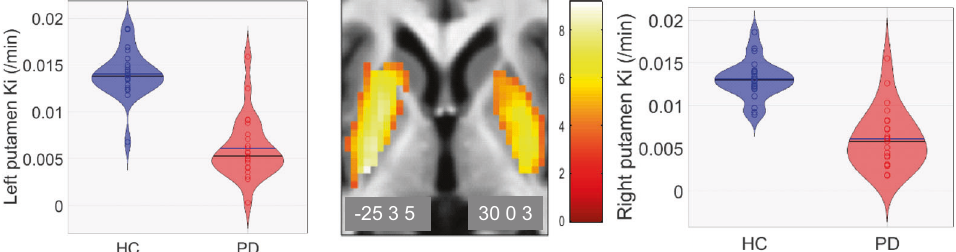
Fig. 5 Changes in dopaminergic neurotransmission. Effect of disease on dopaminergic function measured by [ 18 F]DOPA PET. Results are displayed at p < 0.001 uncorrected over the mean structural image of the whole population. Color scales are proportional to t